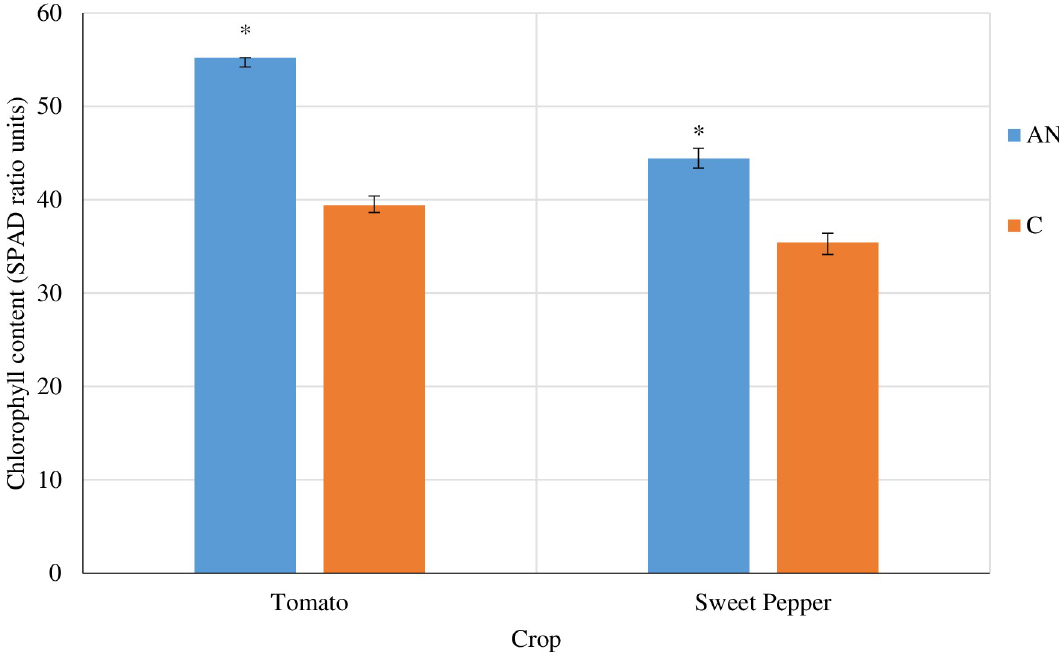
Fig 2. Effect of A . nodosum extract on chlorophyll content of greenhouse-grown tomato and sweet pepper. Treatments: AN- 0.5% foliar spray; C- Control. Values are means ± SD (n = 60). Student’s t-test ( P -0.05) was used to compute significant differences among the extract and control on chlorophyll content 45days after treatment. � represents significant differences where p-value was less than